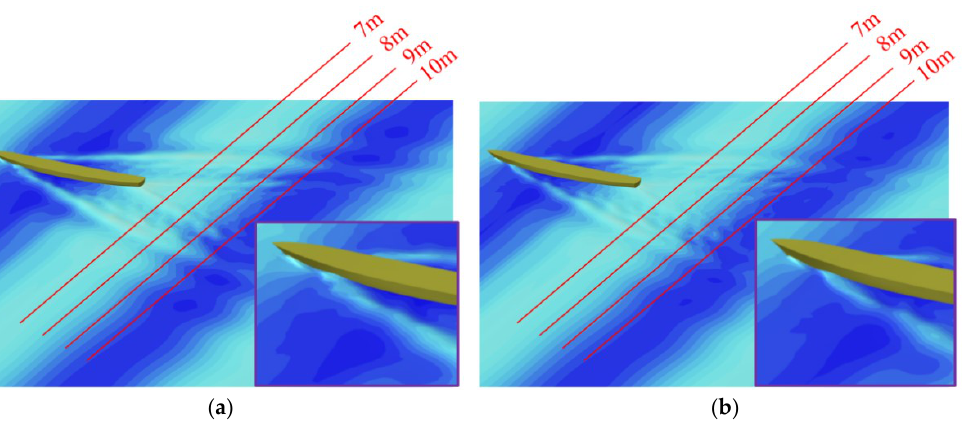
Figure 24. Free-surface elevation of the hull under the action of bow foil with different span lengths and different spring stiffness. ( a ) h = 0.4 m k = 20 N × m/rad. ( b ) h = 1.0 m k = 200 N × m/rad.